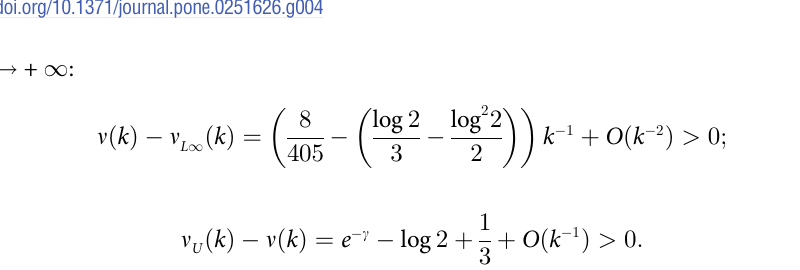
Fig 4. Parameter space detail. Zooming in to the parameter neighborhood of ν 1 and ν L 0 , note that the point with B = e − γ π 2 /12, which we got from the Taylor series of the power of the gamma function, is actually inside the shaded area, so does not represent a bound; but a point at slightly lower B = 0.45965 is on the edge, so represents a lower bound. These points give zero error at approximately k = 0.1003 and k = 0.0708, respectively (see their errors, or margins, in Fig 5). We do not have analytic formulations for these numeric and graphical